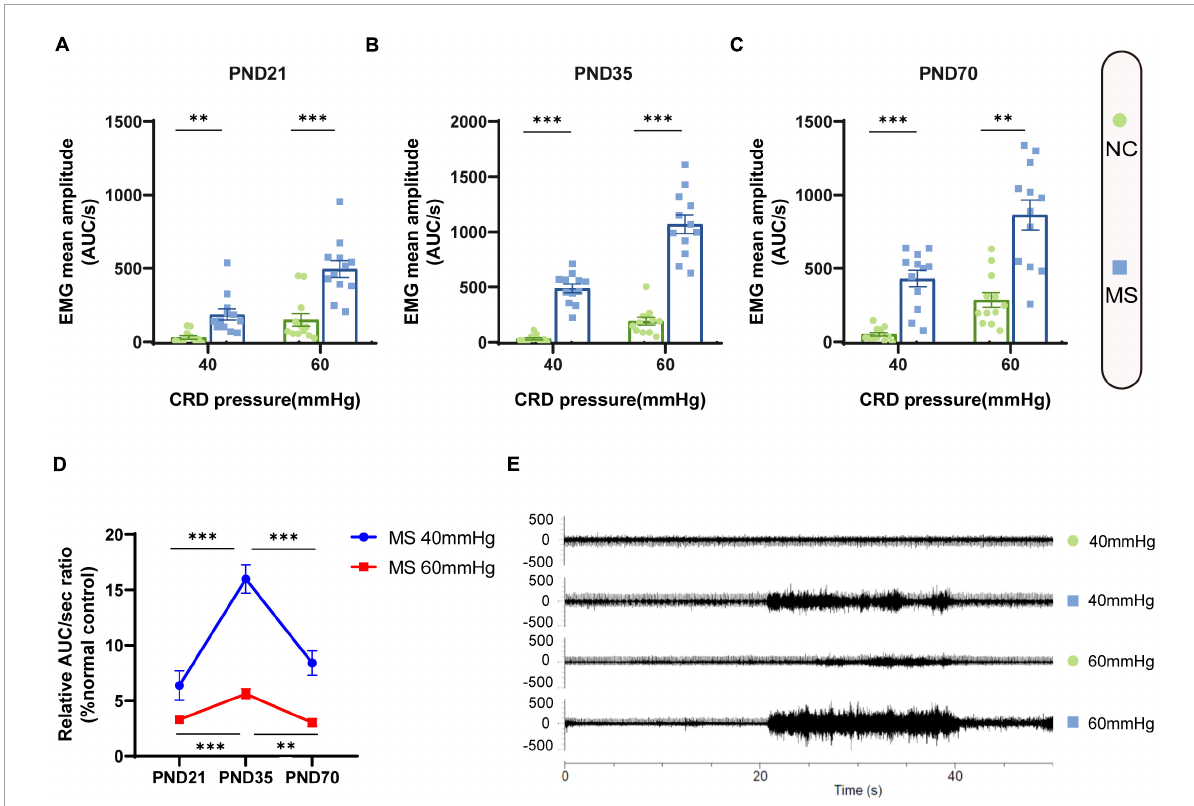
FIGURE2 Visceral hypersensitivity occurred in MS rats from the post-weaning period to adulthood and was more pronounced on PND35. (A–C) VMR amplitudes to 40 and 60 mmHg CRD on PND21 (A) , PND35 (B) , and PND70 (C) were significantly higher than those of NC rats. On PND21: NC, n = 12; MS, n = 12. On PND35: NC, n = 12; MS, n = 12. On PND70: NC, n = 12; MS, n = 12. All data were given as mean ± SEM. ∗∗ P < 0.01, ∗∗∗ P < 0.001, two-tailed unpaired Student’s t -test. (D) The relative VMR ratios of MS to NC rats in three different age periods. The relative VMR ratios of MS rats to NC rats on PND35 were significantly higher than that of PND21 and PND70. All data were given as mean ± SEM. ∗∗ P < 0.01, ∗∗∗ P < 0.001, one-way ANOVA test followed by least-significant difference test. AUC/s, the area under the curve per second. (E) The representative external abdominal oblique muscle EMG recordings of NC and MS